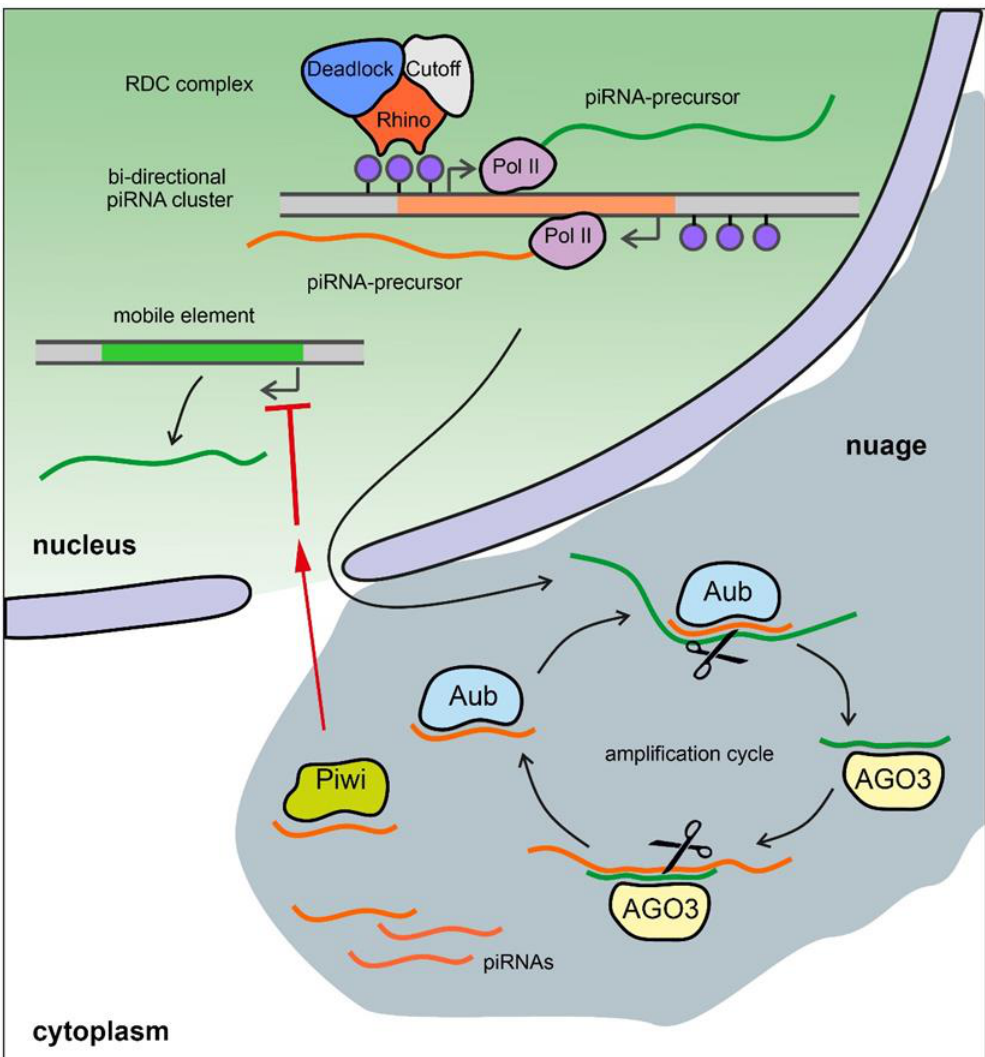
Figure 3. piRNA biogenesis in Drosophila germ cells. Bi-directional piRNA clusters are recognized by the RDC complex with the aid of histone modification H3K9me3 (blue dots) and are transcribed by Pol II machinery with the production of long unspliced transcripts of piRNA precursors. They are exported from the nucleus in the perinuclear nuage granules and are presumably cleaved by endonuclease Zucchini forming the 5′ -end of the future piRNA (not shown). The cleaved transcripts are loaded into PIWI clade protein Aubergine (Aub) and then trimmed from the 3′ -end by an unknown trimmer nuclease (not shown). Aub loaded with guide antisense piRNA recognizes and cleaves the complementary sense transcript producing the 5 ′ -end of a new sense piRNA. The new piRNA is loaded into PIWI clade protein AGO3 and, in turn, performs cleavage of the complementary antisense transcript. This step generates a new antisense piRNA that is identical or very similar to the initiating piRNA (ping-pong amplification cycle). Piwi proteins loaded by antisense piRNAs translocate into the nucleus where they suppress transcription of TEs with complementary sequences by a co-transcriptional repression mechanism.